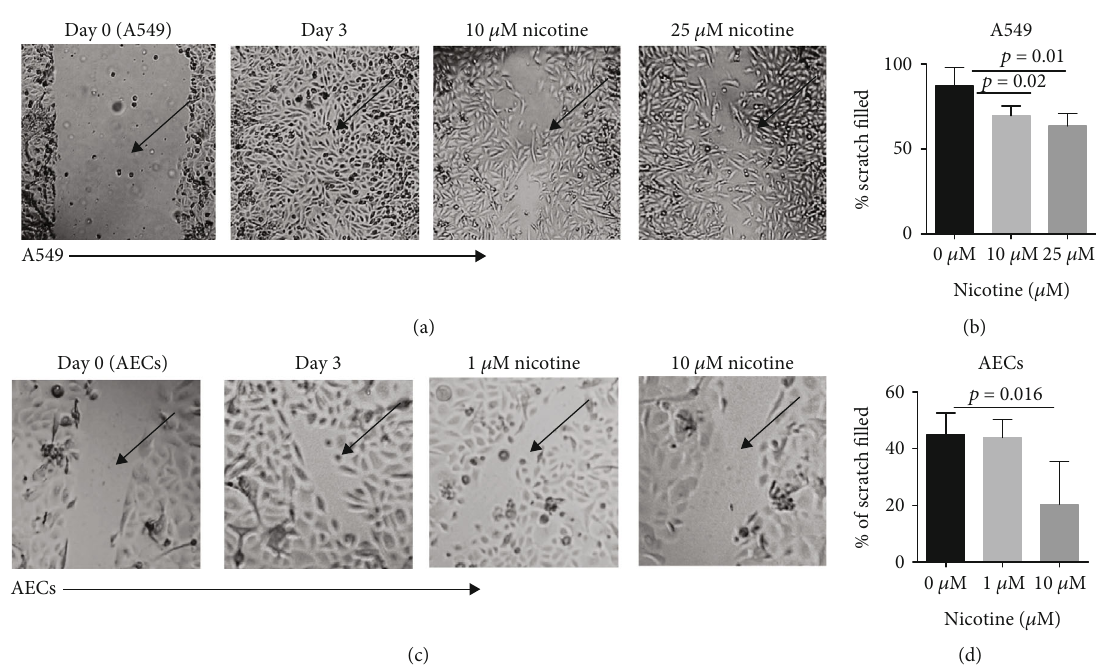
Figure 1: Nicotine inhibits the repair capacity of lung epithelial cells. A549 or AECs exposed to nicotine at various concentrations for 72h were scratched, and the capacity of the cells to fi ll scratch was determined. Quantitation of percent scratch fi lled was calculated using the ImageJ software. (a) Scratch repair at 72h in A549 cells. (b) Quantitation of the same. (c) Micrographs display the scratch repair at 72h in AECs. (d) Quantitation of the same. Data is presented as the mean ± SD of biological replicates of n = 4 for A549 and n = 5 for AECs. Arrows point to the scratches. Scale for micrograph is 20 μ m.